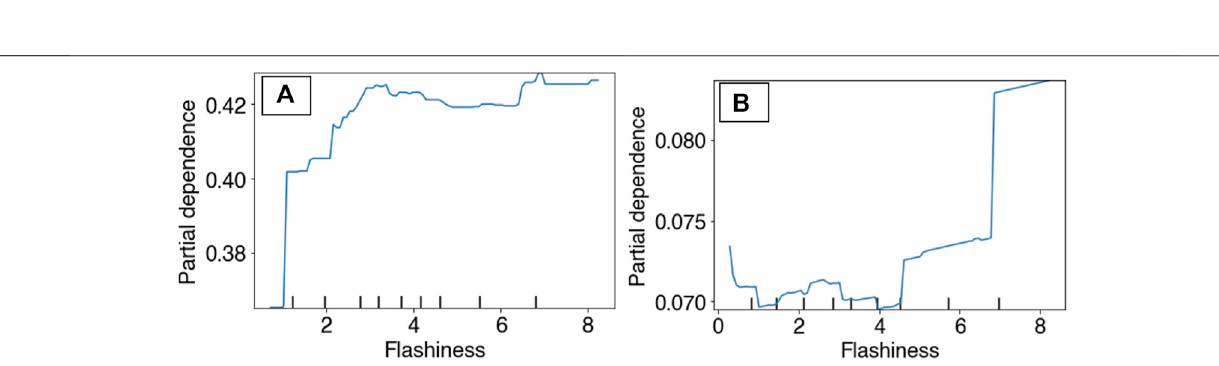
FIGURE 8 | Partial dependency plots for surface water fl ashiness in both the RBT occurrence ensemble (A) and the hybridization ensemble (B) models.